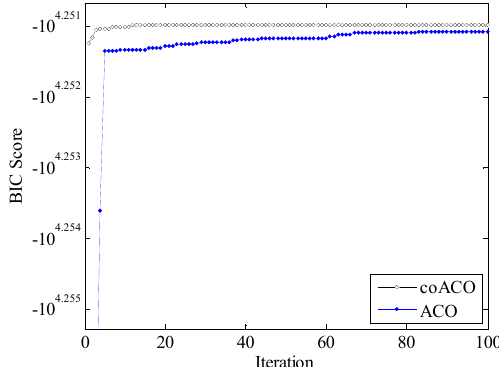
Figure 6. Evolution curves of the average BIC score achieved by ACO and coACO on the ASIA dataset with n = 5000.